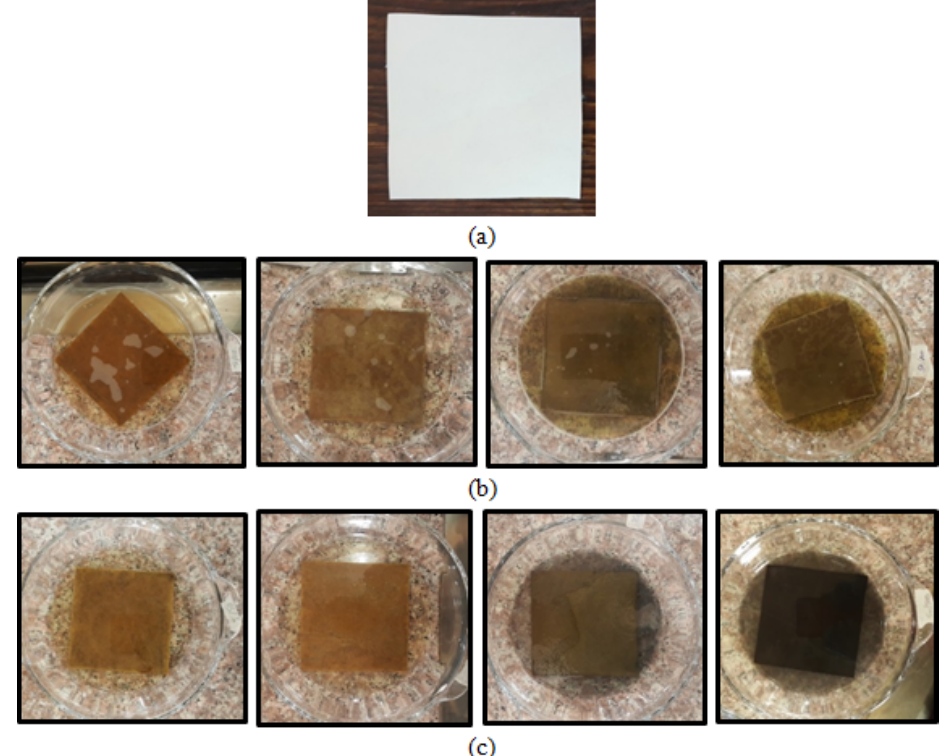
Figure 1. Cellulose papers: (a) before being impregnated with AgNPs, (b) during preparation of AgNPs with a NaBH 4 / AgNO 3 ratio of 2 : 1, and (c) during preparation of AgNPs with a NaBH 4 / AgNO 3 ratio of 10 : 1.